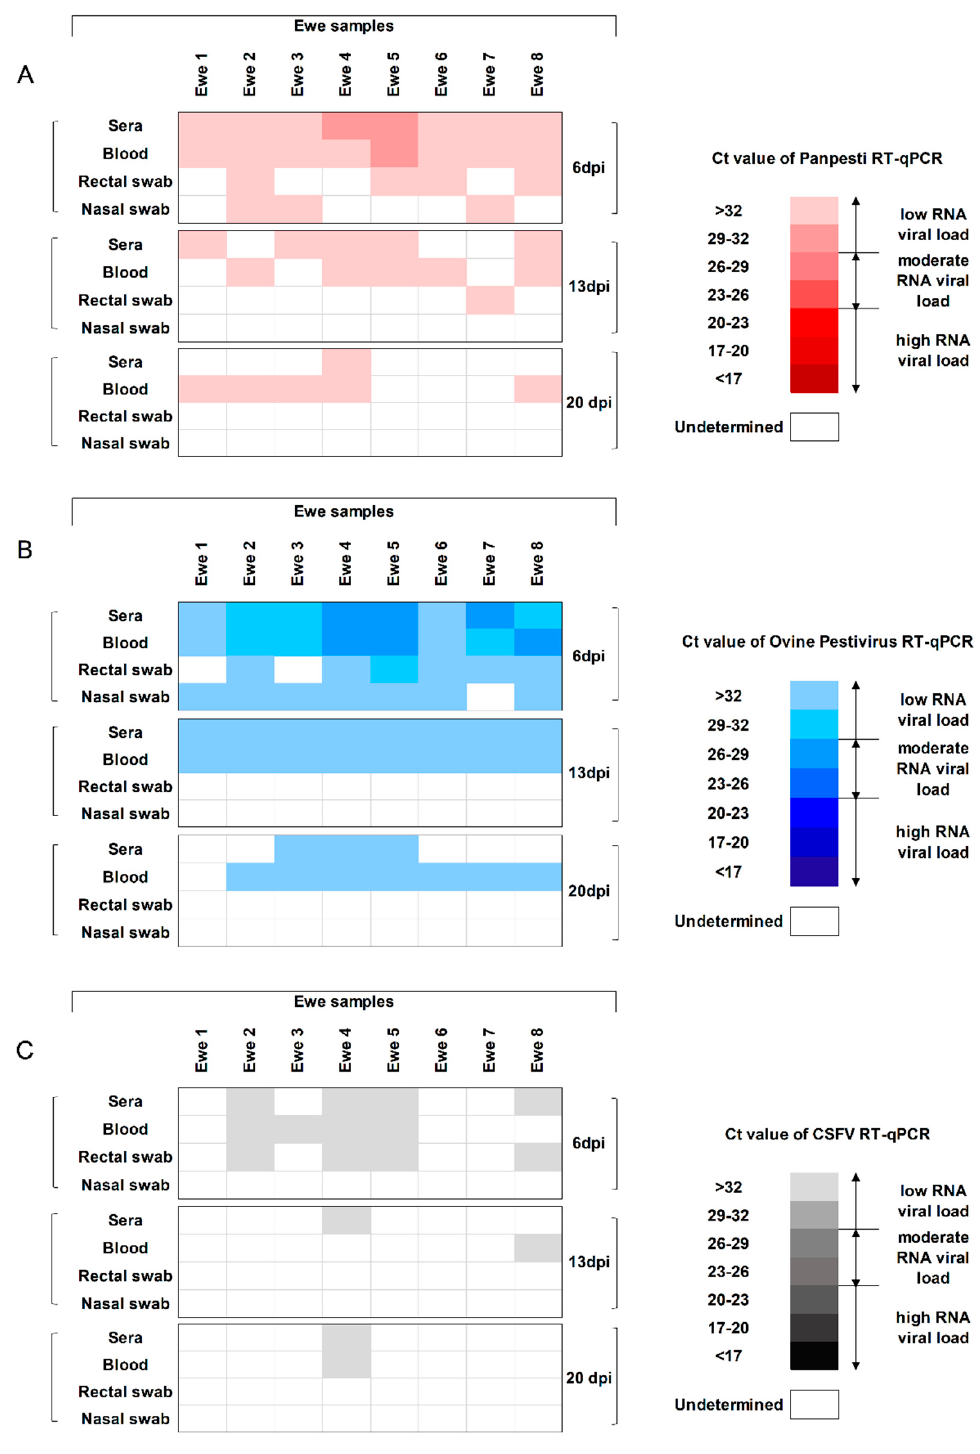
Figure 2. Weekly detection of OVPV RNA in sera, blood, and nasal and rectal swabs from infected ewes. The OVPV RNA was analyzed by ( A ) Pestivirus RT-qPCR [21], ( B ) the new specific OVPV RT-qPCR, and ( C ) specific CSFV RT-qPCR [22]. The RNA load, according to the Ct value, is represented as low, moderate, or high by the intensity of the red, blue, or gray colors in the scale for ( A ), ( B ), and ( C ), respectively. Ct values above 40 were considered as negative. The excretion of OVPV was found during a short time after infection. The majority of OVPV RNA-positive nasal and rectal swab samples being found at 6 dpi by both RT-qPCR techniques and only one rectal swab sample was positive at 13 dpi by the Pestivirus RT-qPCR. From 20 dpi and until